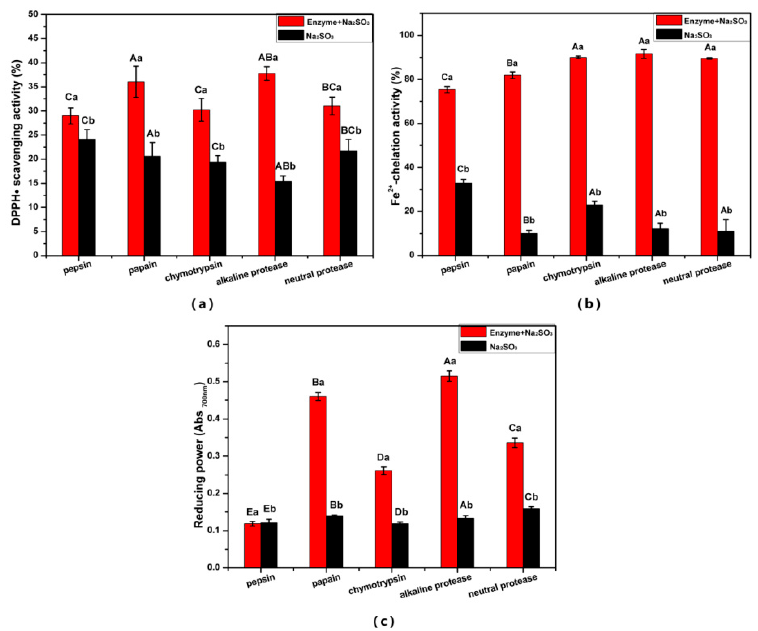
Figure 1. Effects of enzymes species (9 U/mg) on the antioxidant activity of eggshell membrane enzymatic hydrolysate (ESM-EH) with the assistance of 30 mM Na 2 SO 3 . ( a ) DPPH • -scavenging activity; ( b ) Fe 2+ -chelating ability; ( c ) reducing power. Differences in lowercase letters indicate significant differences between enzyme + Na 2 SO 3 treatment group and Na 2 SO 3 treatment group ( p < 0.05), and the difference of capital letters shows the significant difference of enzyme species ( p < 0.05).